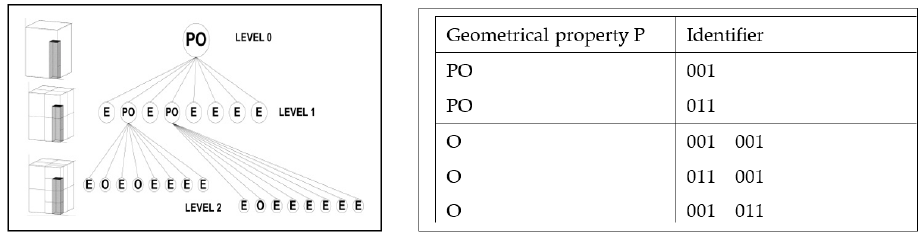
Figure 3. Spatial approximation of an object by a two-level octree. ( left ) Spacial approximation of 3D object; ( right ) Matrix of octant identifiers and properties for the approximated object.